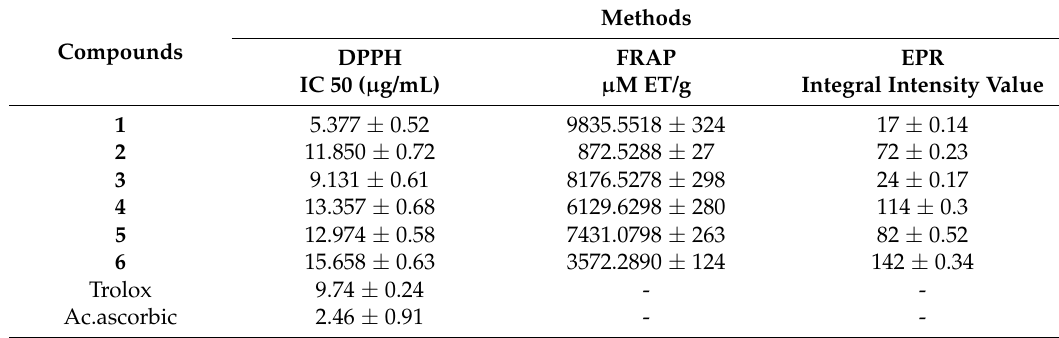
Table 1. The antioxidant activity of indolyl-hydrazinyl-thiazoles 1 – 6 determined by different methods.